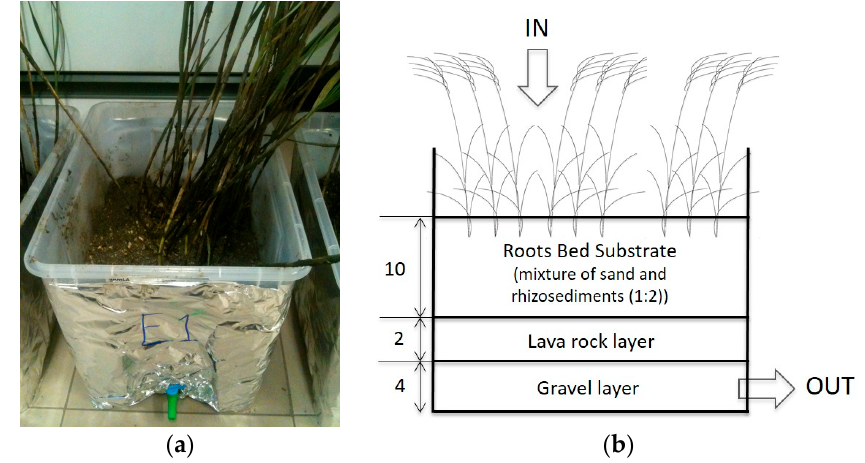
Figure 1. ( a ) Picture of one of the assembled CW microcosms; ( b ) Vertical cross ‐ section of an experimental constructed wetland planted with P. australis showing height (in cm) and composition of the three layers.